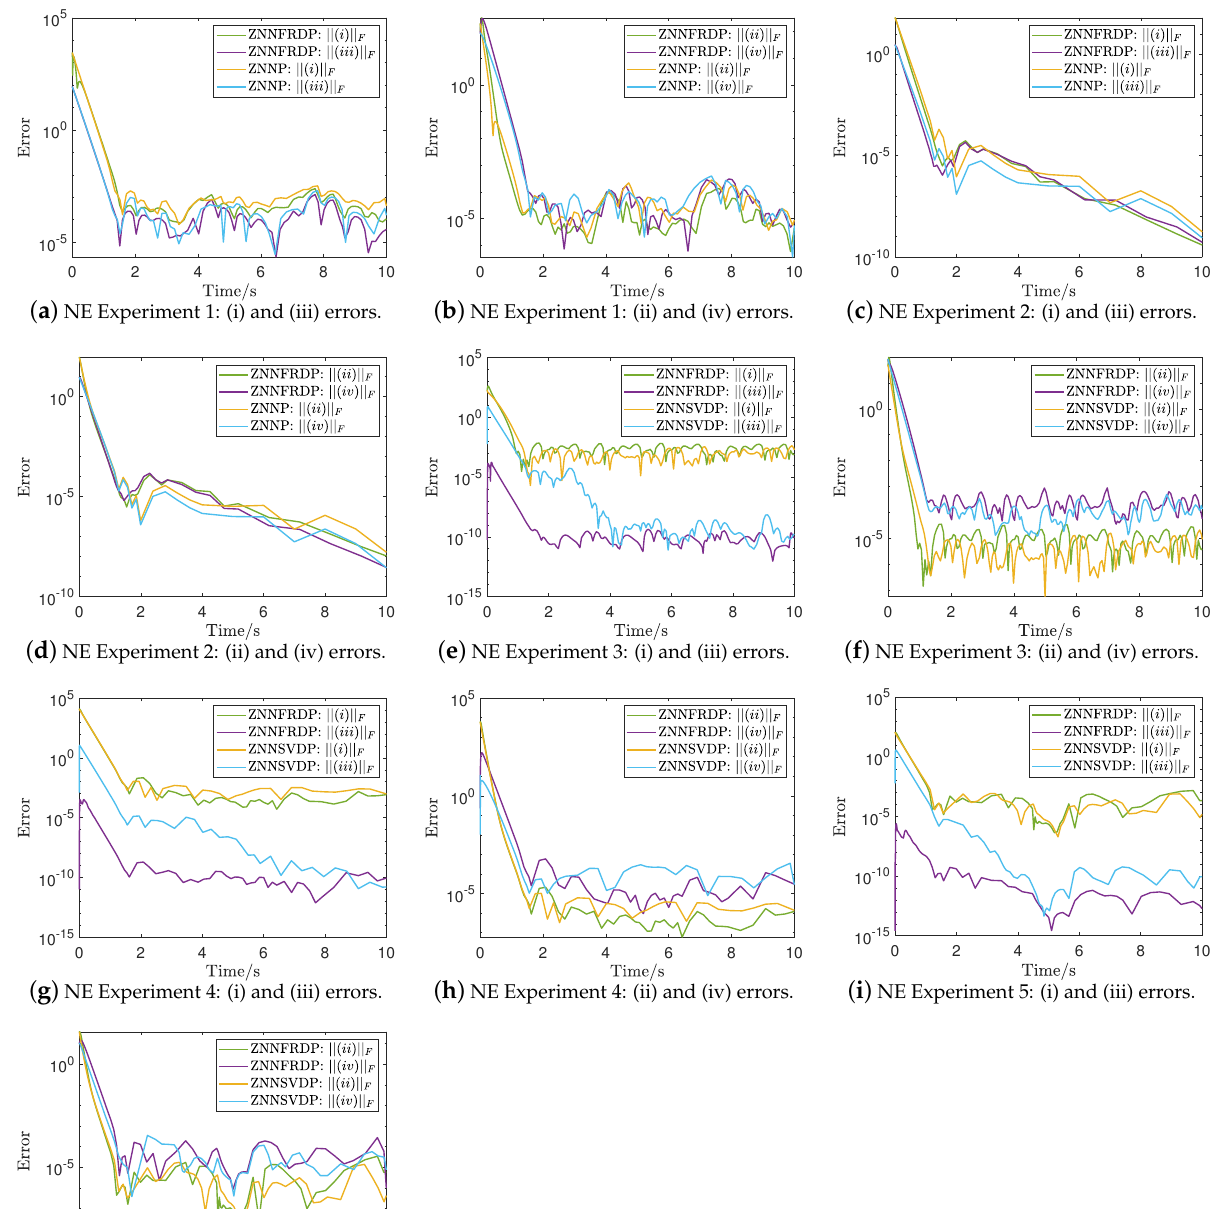
Figure 3. MP equations (i)–(iv) errors of the ZNNFRDMP, ZNNSVDMP and ZNNP models solutions in NEs in Sections